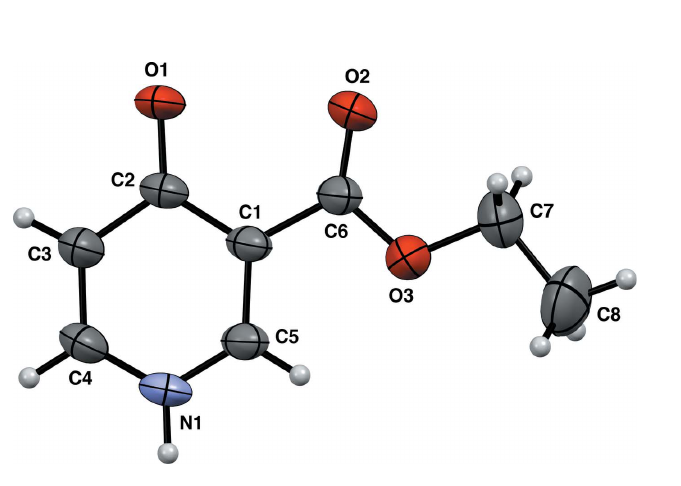
Figure 1 The molecular structure of the title compound with displacement ellipsoids drawn at the 50% probability level.